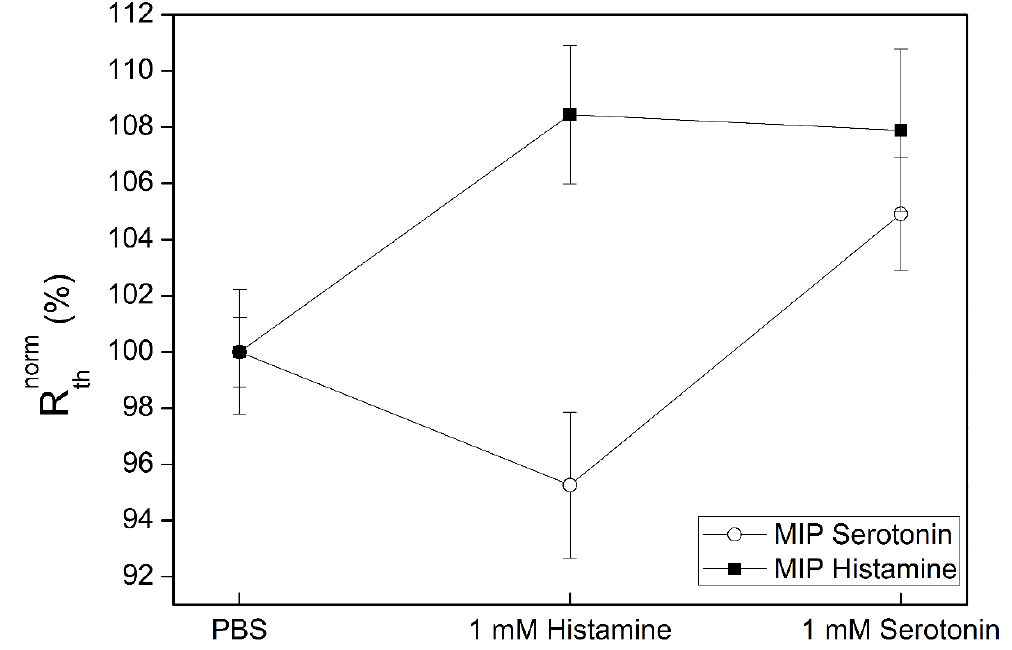
Figure 7. Thermal response of histamine- and serotonin-sensitive sensors spots upon exposure to a solution with a concentration of 1 mM histamine (first) and 1 mM serotonin (second) in PBS. The experiment has been performed by sequential additions of the target molecules to the sensor quadrants without intermittent washing steps.